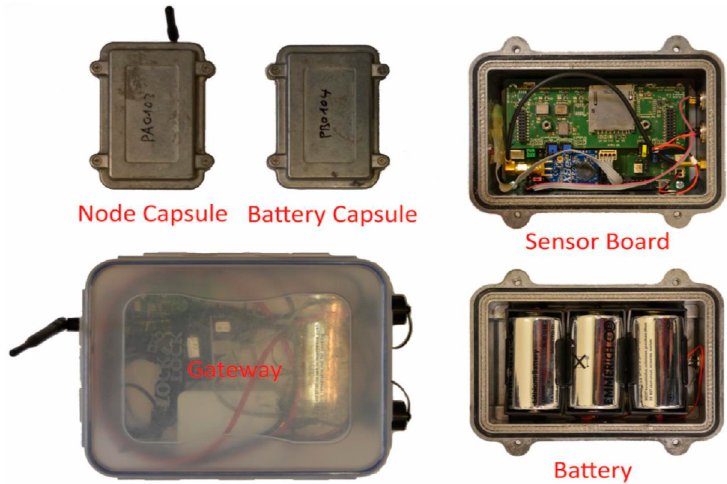
Figure 1. Components of X-SLEWS (From [11]). The node capsule comprises a base board for basic operation and an add-on board for sensing and storing function. The battery capsule allocated with three 3.6-V batteries provides the power supply to the node capsule while measuring and data transmitting. The gateway receives and saves the retrieved data from all the nodes in the network and broadcasts the updated clock periodically to connected nodes.